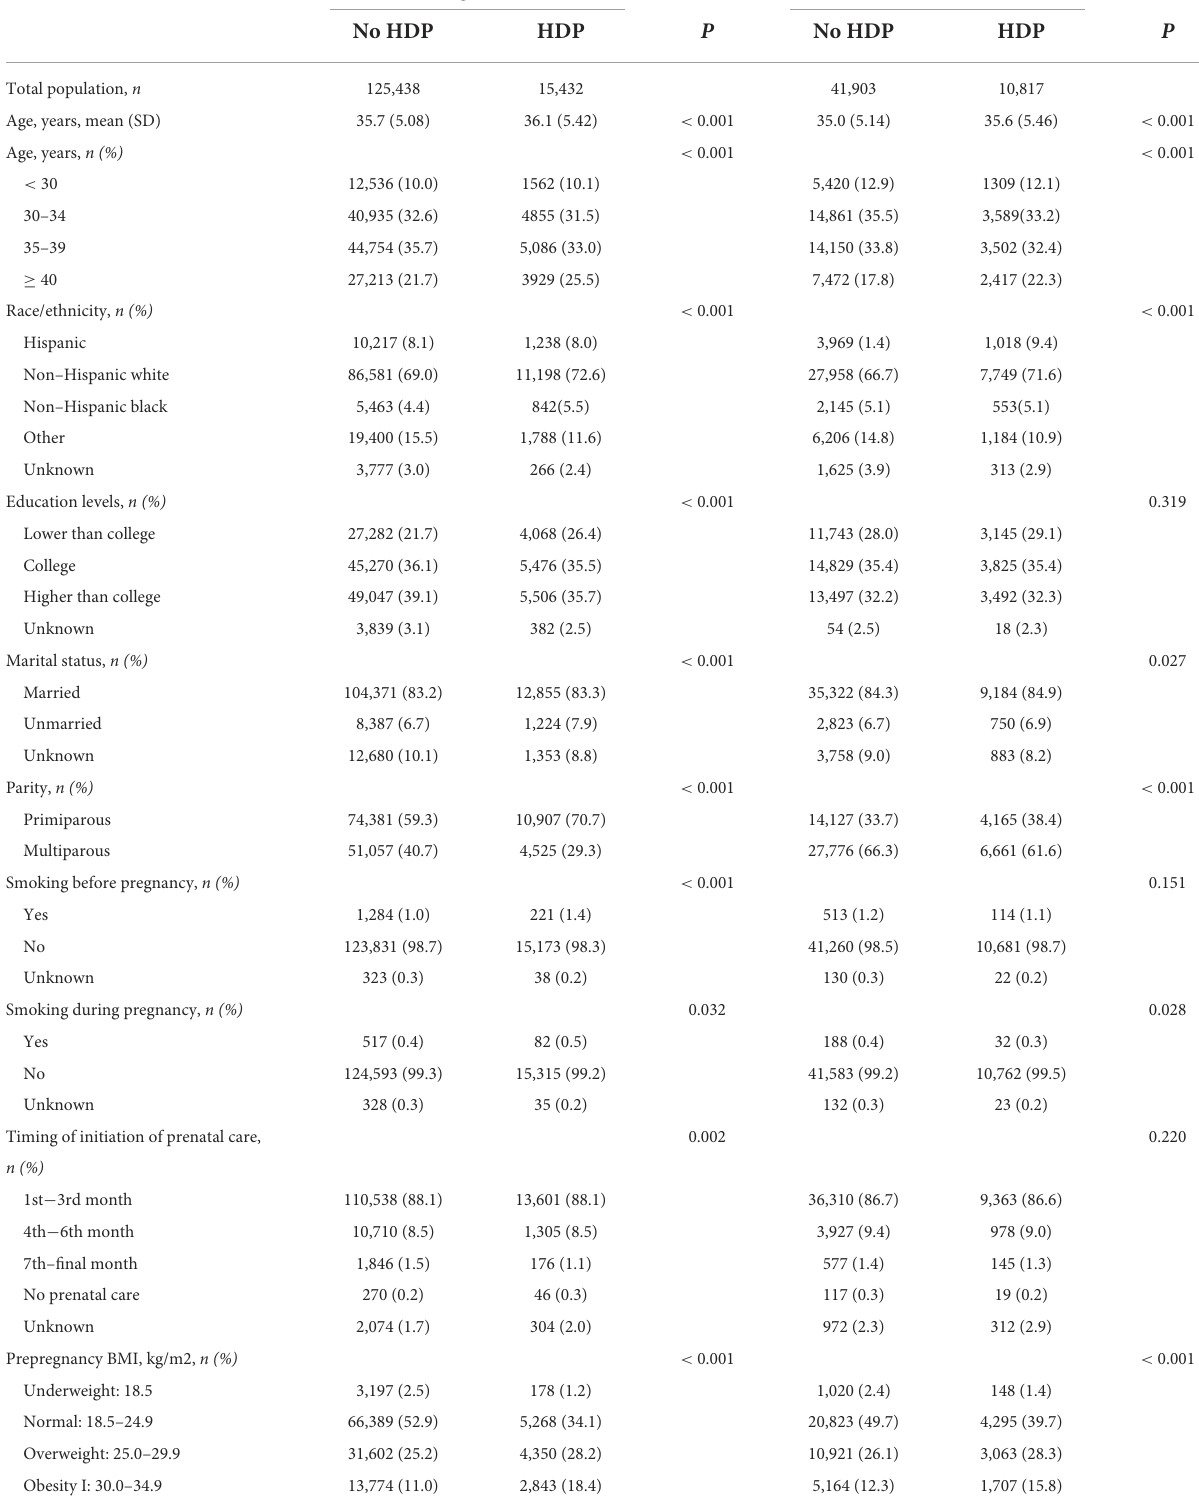
TABLE 1 Demographic characteristics according to HDP in ART mothers–NVSS,